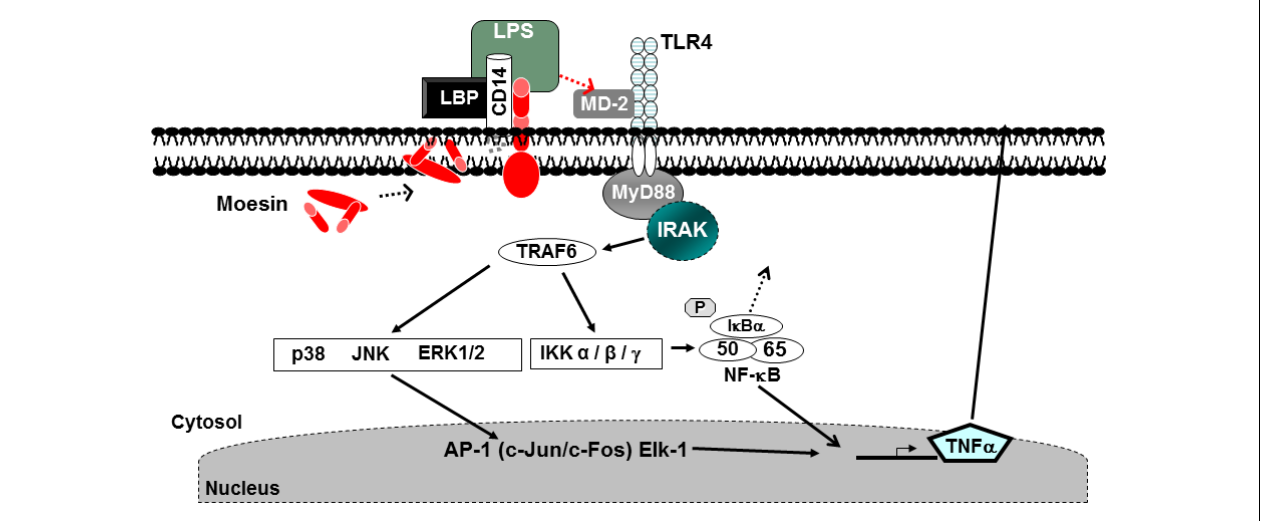
to theTLR4 and MD-2 activating the MyD88. Signaling through this mechanism leads to the production of pro-inflammatory cytokines (Zawawi et al.,